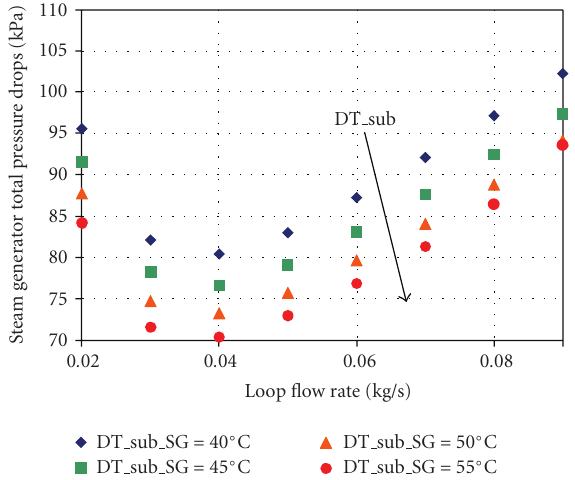
Figure 10: Steam generator pressure drops as a function of inlet subcooling (Data obtained with p = 30.5bar − power =